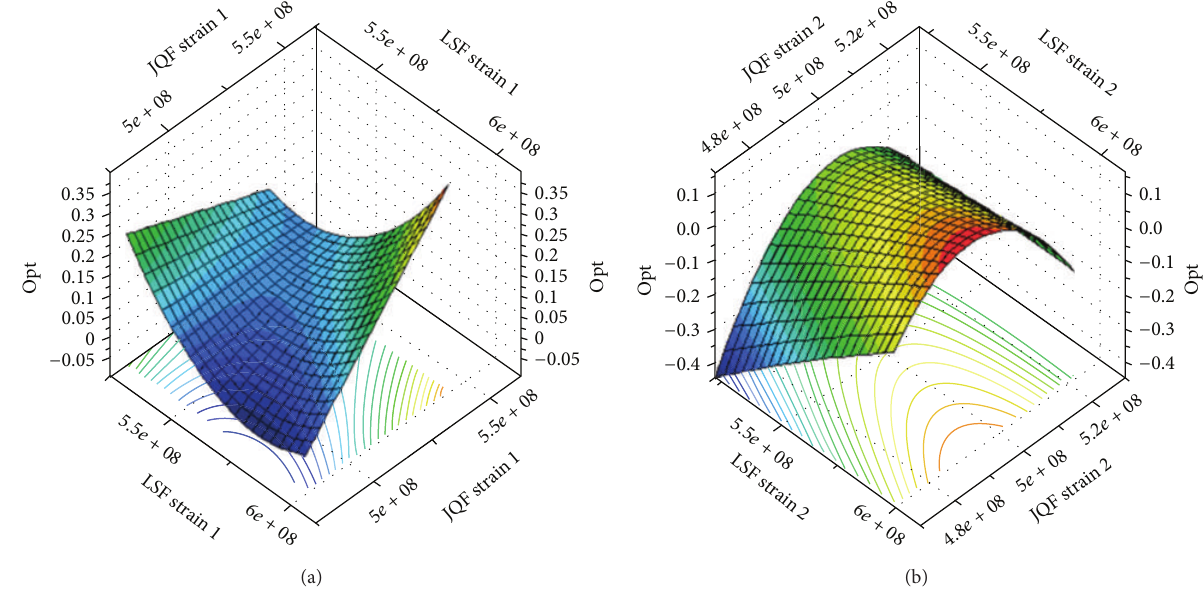
Figure 6: Response surface models for objective function. Table 2: Input variables and value range.